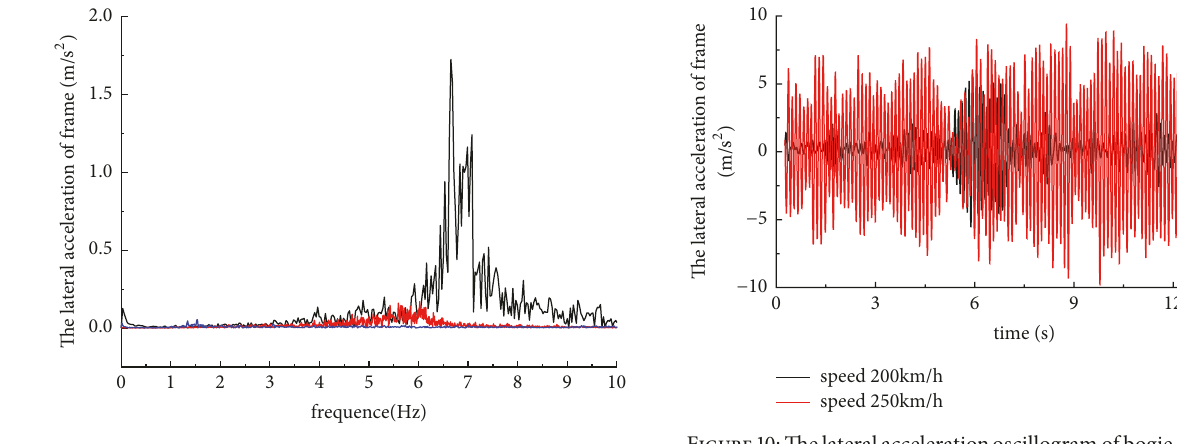
Figure 10: Thelateralaccelerationoscillogram of bogie frameunder different speeds.